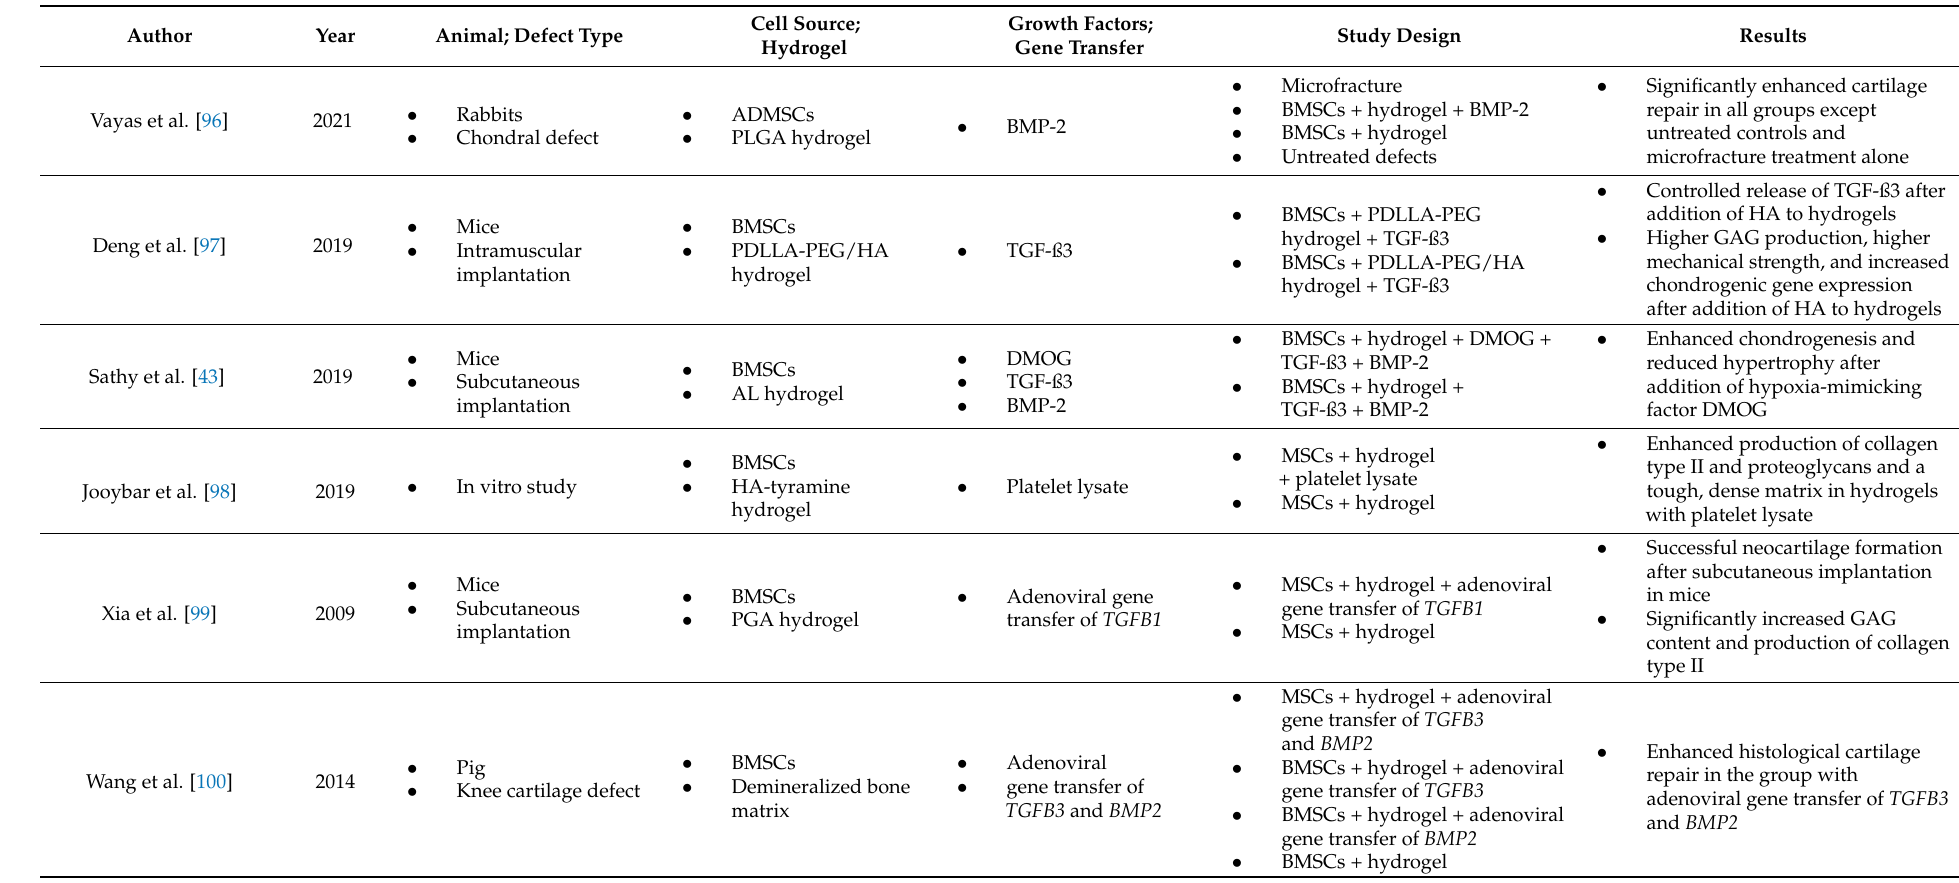
Table 5. Studies examining the combined use of MSCs, growth factors/gene transfer, and hydrogels for cartilage